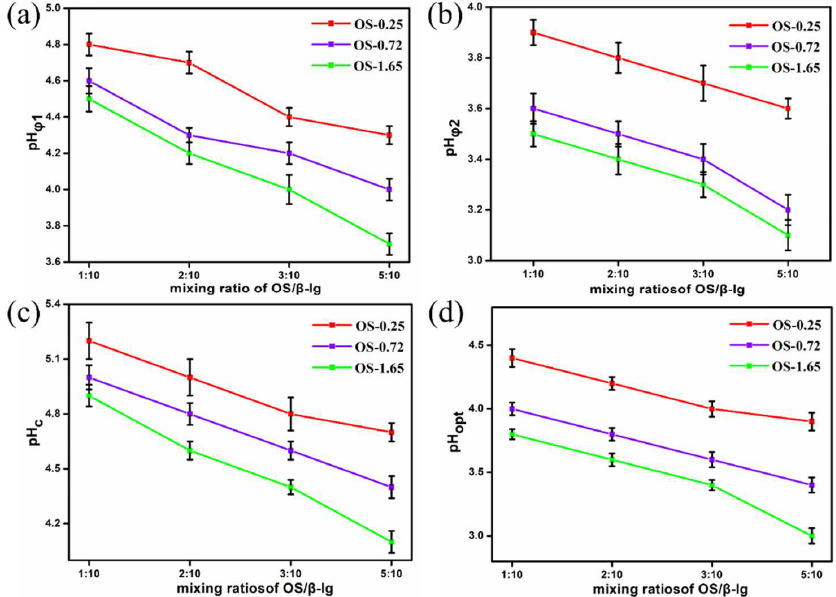
Figure 3. The changes in pHφ1 ( a ), pHφ2 ( b ), pHc ( c ), and pHopt ( d ) of OS/β-lg complex dispersions at different DSs and OS/β-lg mixing ratios.